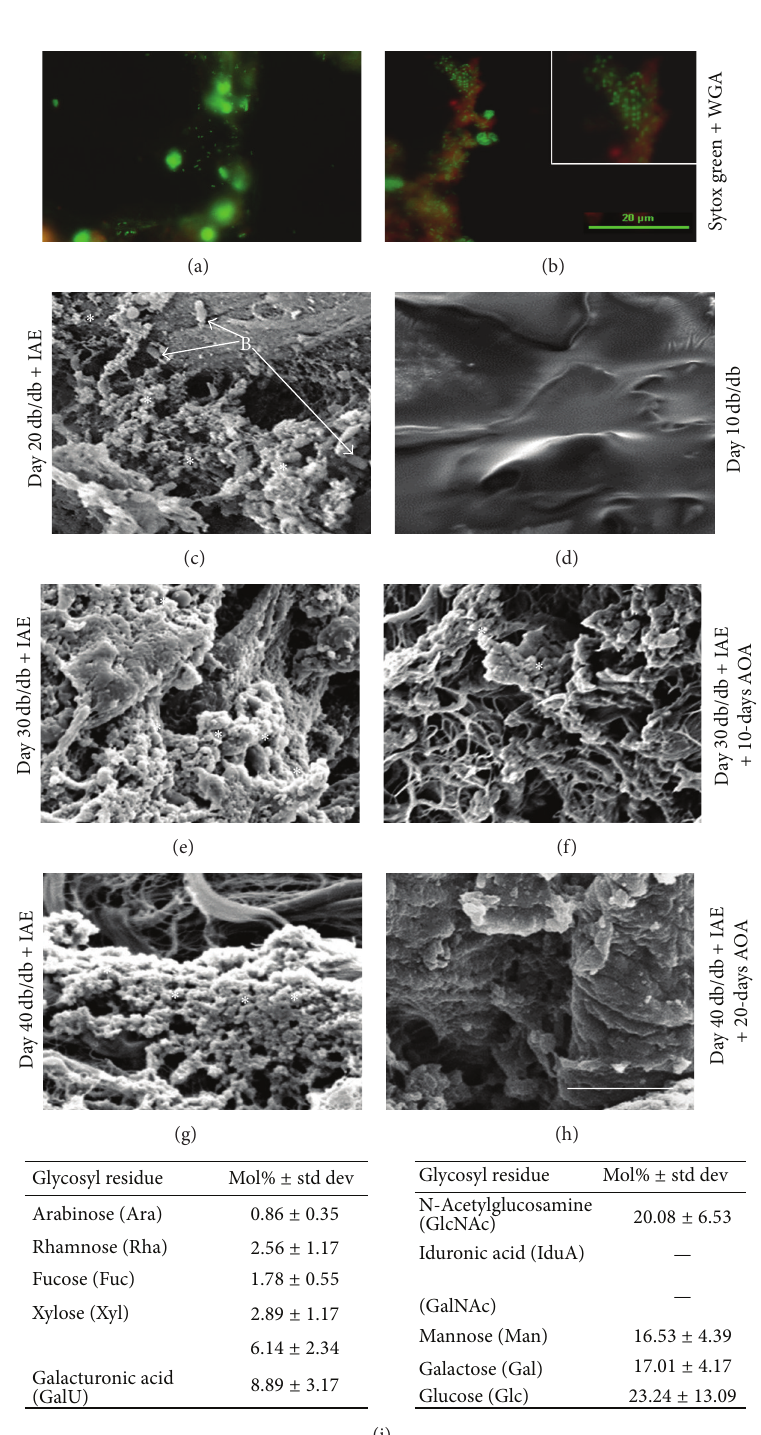
Figure 8: Morphological characterization of biofilm in chronic and AOA treated wounds. (a, b) Fluorescent microscopy of frozen sections of chronic wounds IAE treated at 20 days after wounding, stained by Sytox green for bacterial DNA and wheat germ agglutinin conjugated with Texas Red for the tissue and biofilm matrix, shows presence of biofilm. (c) SEM shows bacteria embedded in a biofilm-associated matrix (stars) with presence of bacteria [B] in chronic wounds at day 20 after wounding and treatment with IAE. (d) Day 10 db/db wounds without inhibitors to illustrate how the tissue looks like in non-IAE treated wounds. (e) Chronic wounds treated with IAE at day 30 after wounding show more biofilm than at day 20 (c) and much more than the day 30 wounds that were treated with AOA for 10 days (f). (g) Chronic wounds treated with IAE at day 40 after wounding show more biofilm than at day 30 (e) and much more than the day 40 wounds that were treated with AOA for 20 days (h). Scale bar for (c–h) is 5 𝜇 m. (i) Biochemical analysis of the biofilm obtained from chronic